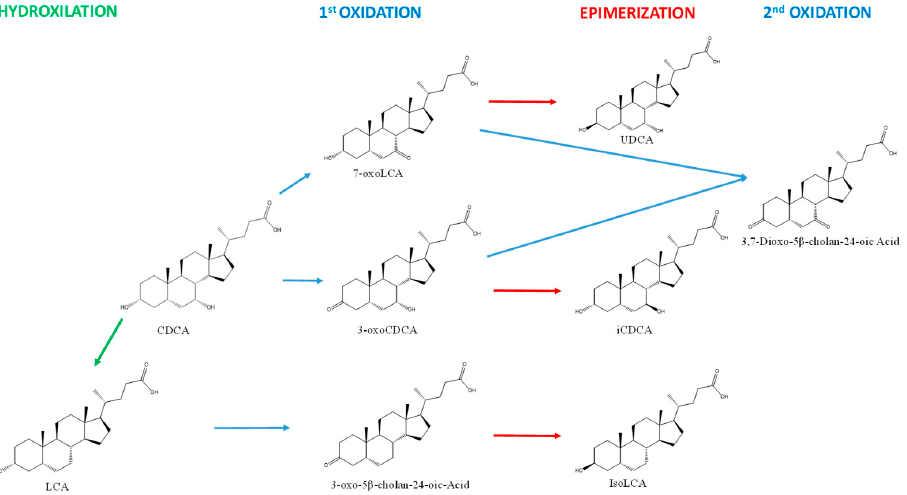
Figure 1. Summary of the expected conversion of secondary BAs by human gut microbiota.